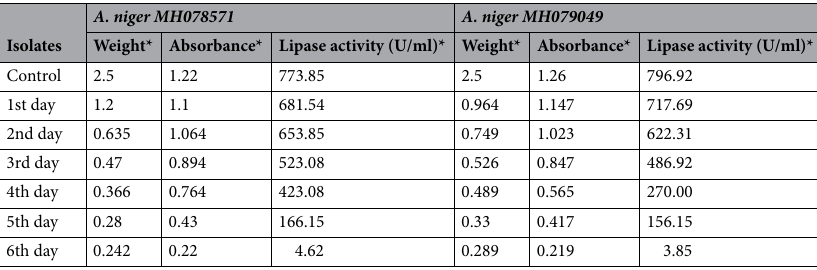
Table 2. The determination of lipase efficiency and activity of both A. niger isolates in degrading chicken fat. *Averages of three replicates.